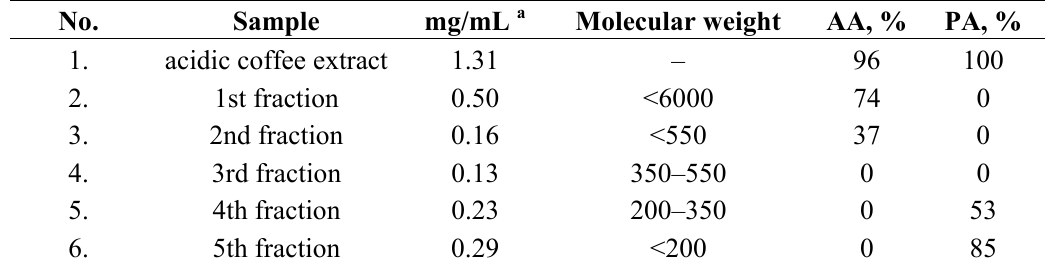
Note: a mg of dry residue per mL of brewed